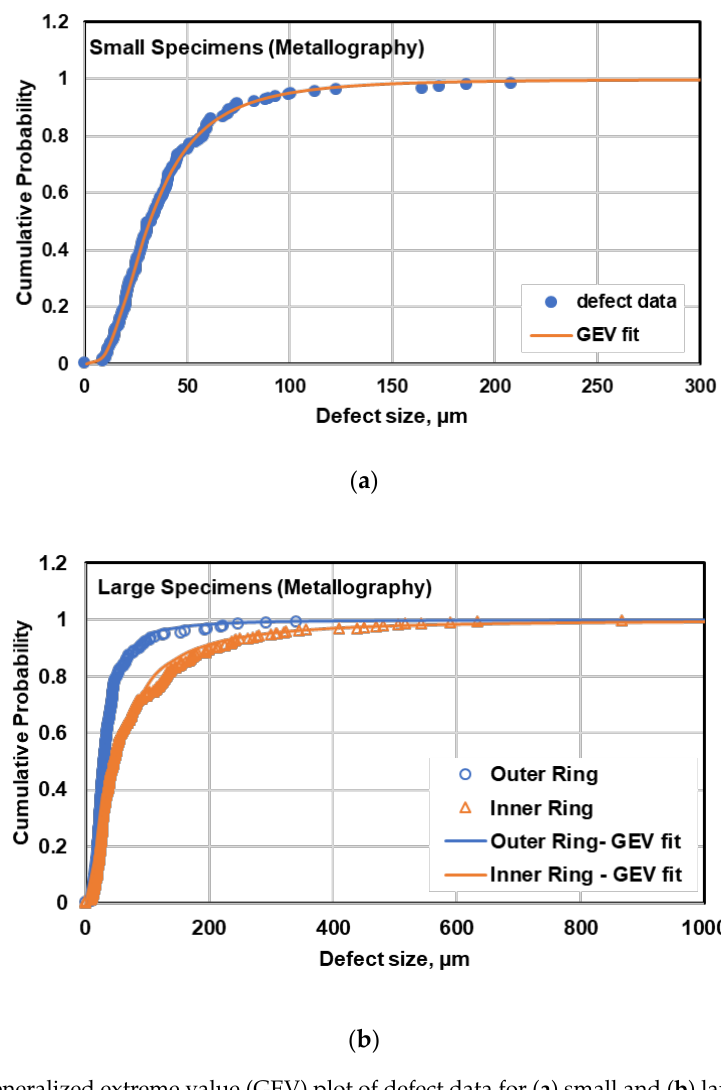
Figure 17. Generalized extreme value (GEV) plot of defect data for ( a ) small and ( b ) large specimens. Table 5. Comparison of the maximum defect estimated by block maxima (BM) approach using metallography (2D) data as well as those estimated by peak-over-threshold (POT) approach using µCT (3D) data with the maximum fata defects observed on fracture surfaces (the unit of the estimates is in µm).